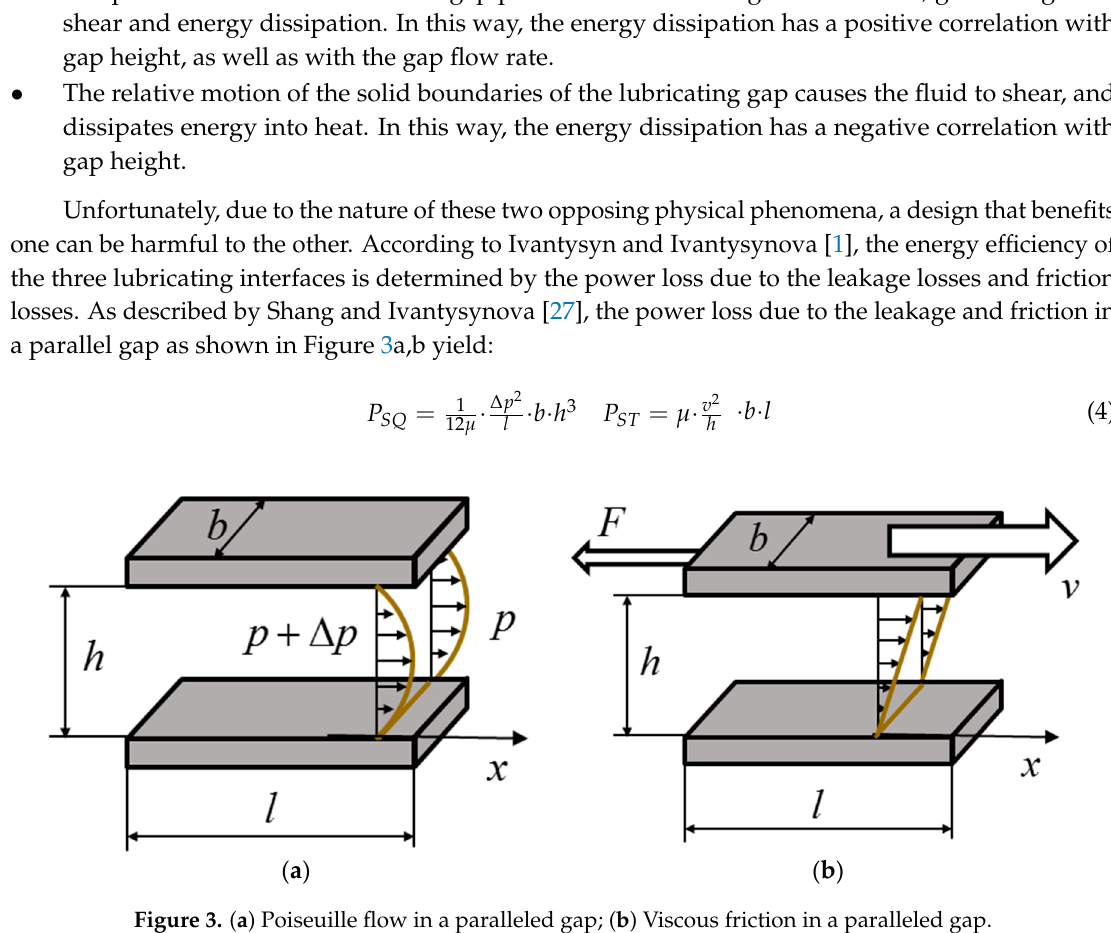
Figure 3. ( a ) Poiseuille flow in a paralleled gap; ( b ) Viscous friction in a paralleled gap.